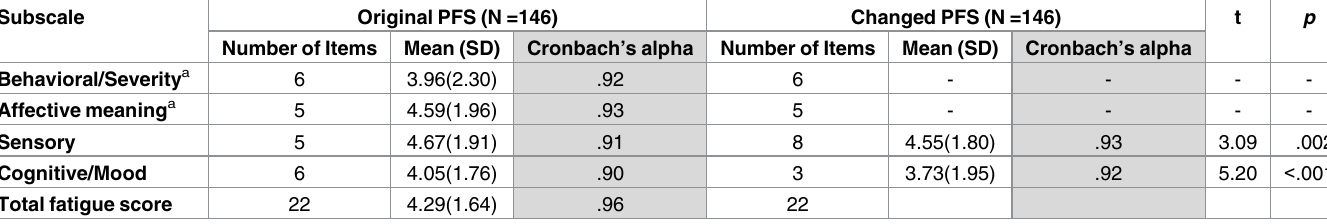
Table 5. Comparison of subscale values and Cronbach’s alpha between original PFS & changed